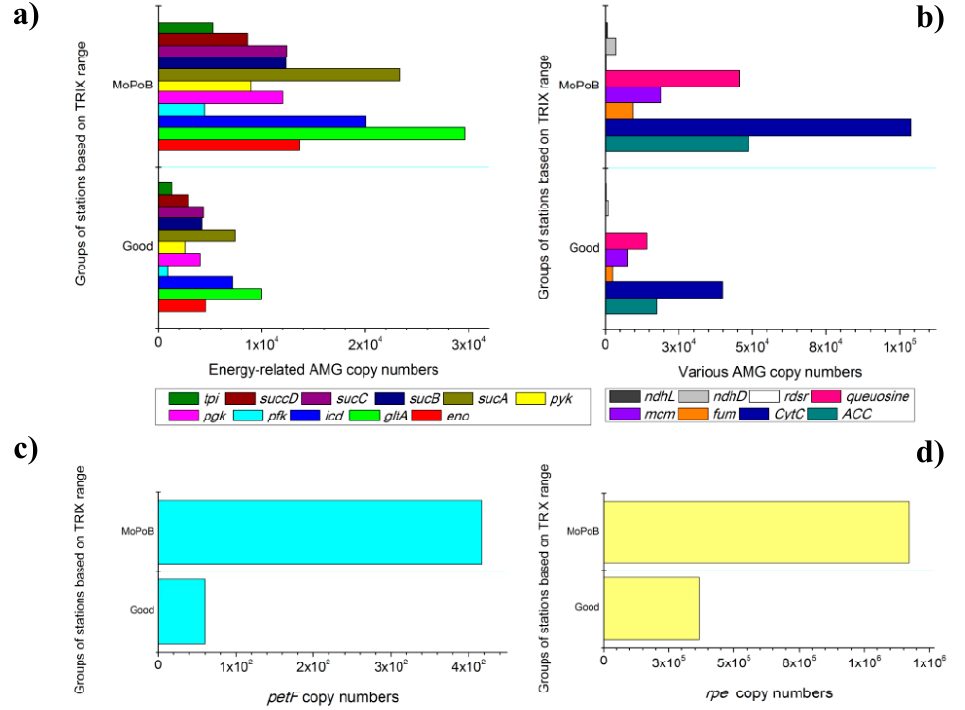
Figure 4. Auxiliary metabolic genes. The normalized abundances of auxiliary metabolic genes that were significantly different between Good and MoPoB group of stations. ( a ) AMGs related to dNTP synthesis and energy production, ( b ): AMGs related to various metabolic processes, ( c ): the petF AMG related to photosynthesis, and ( d ): the rpe AMG related to energy production. Good: stations having good overall ecological quality and MoPoB: stations having poor overall ecological quality, based on the annual TRIX